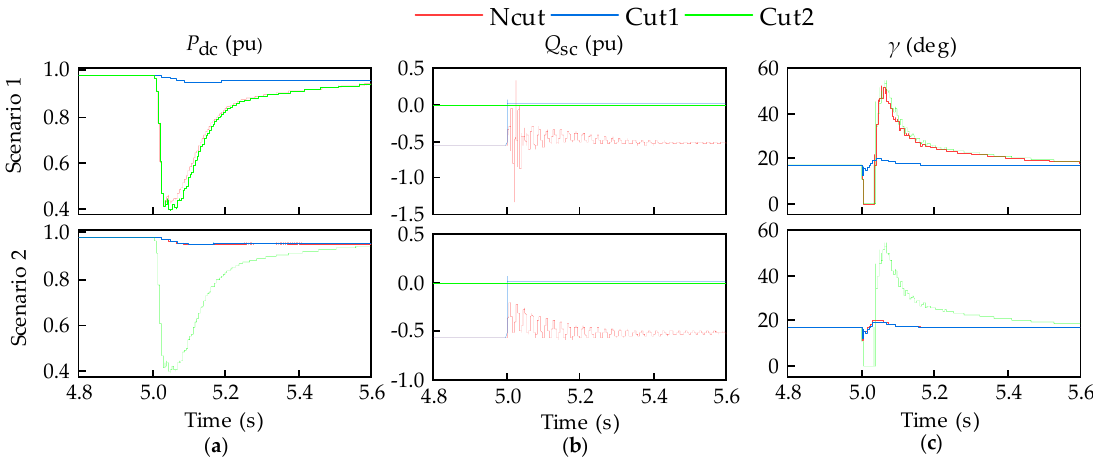
Figure 8. Simulation results during the low bus voltage occasion: ( a ) Active power of the UHVDC in different scenarios; ( b ) Reactive power of SC in different scenarios; ( c ) γ in different scenarios.